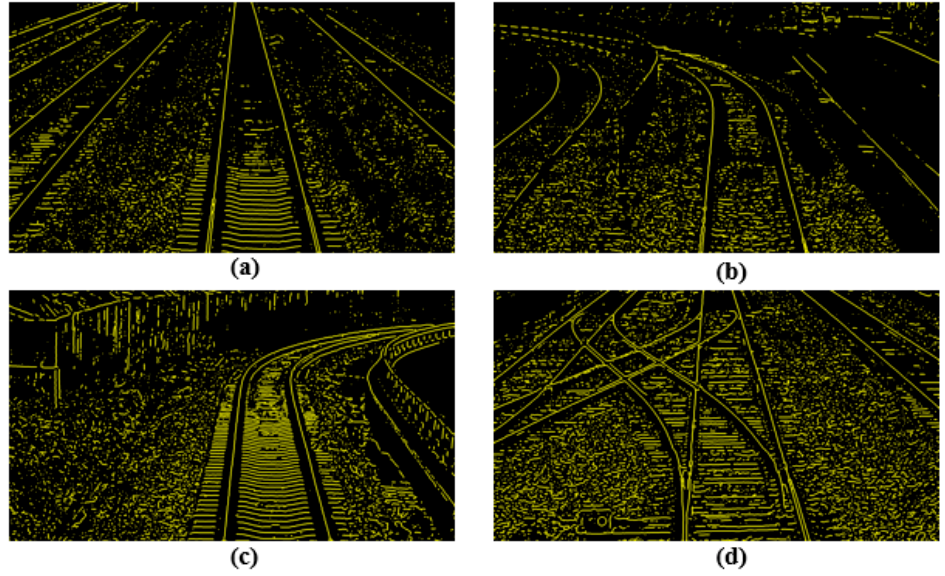
Figure 10. The result of freight railway after improved ZS algorithm processing. ( a ) is a multiple sets of straight track lines, ( b ) is curves with a small curvature track lines, ( c ) is the curved with a large curvature track line, ( d ) is the multiple turnout track lines.